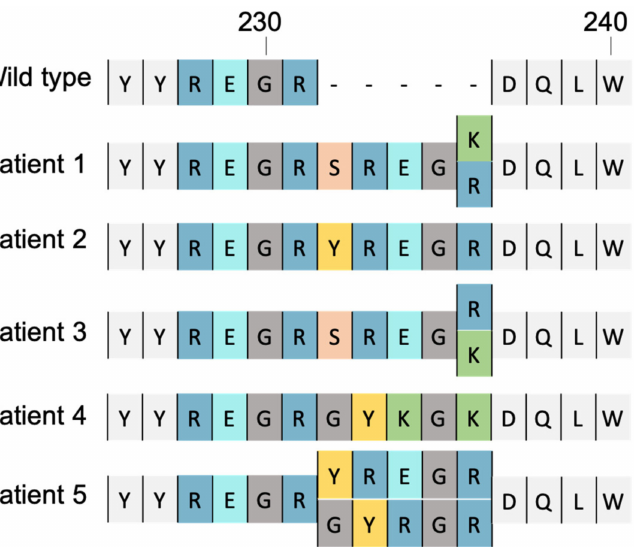
Figure 4. Sequences of wild-type and insert-containing human immunodeficiency virus type 2 (HIV-2) integrase (from codon 226 to 240). Alignment of amino acids sequence of the reference strain and sequences of integrase found in patients after initiating the RAL-based regimen. Insertions described by Le Hingrat and colleagues lead to a high level of RAL and EVG resistance and a moderate resistance to DTG and CAB